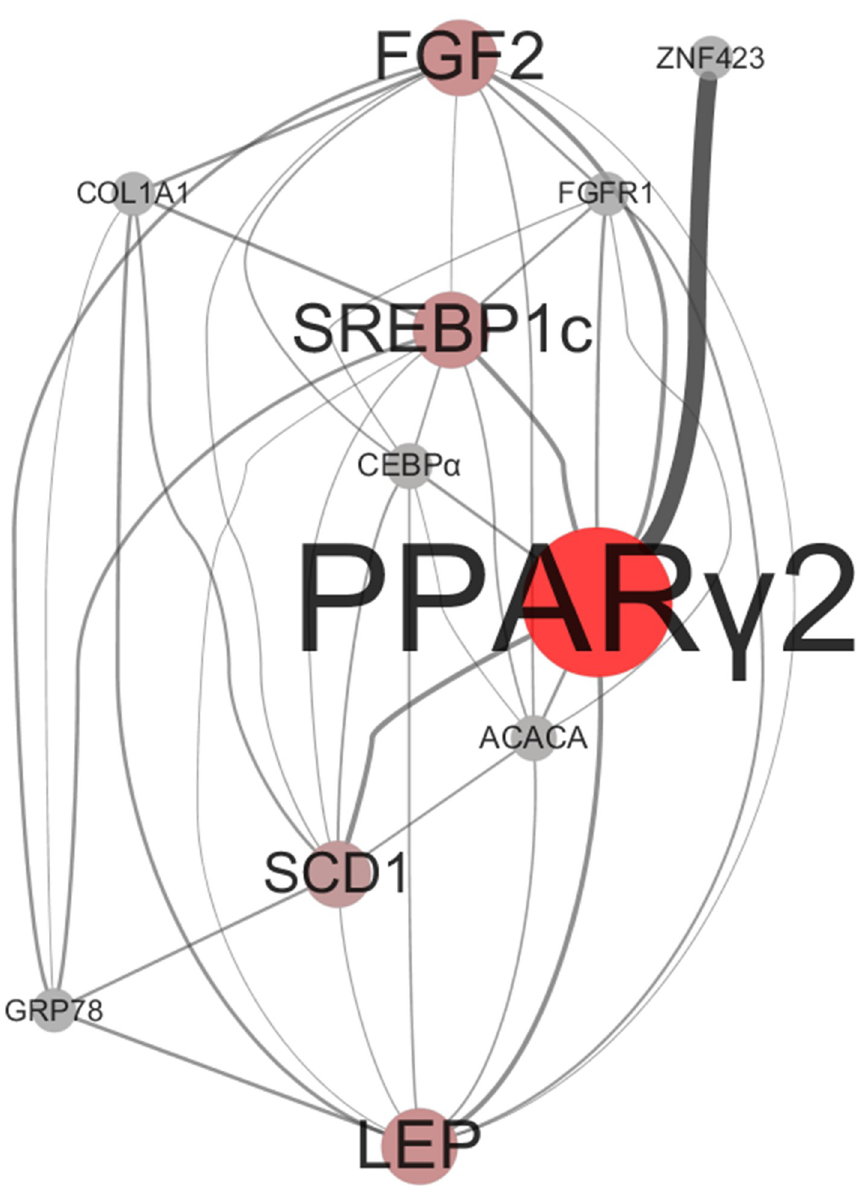
Fig 3. Gene association network composed of five hub genes. Node color and size: red and larger nodes represent hub genes with more links. PPAR γ 2 appears to be the super hub gene in the network with the highest connectivity. metabolism-related genes were placed in hierarchically arranged layers from top to bottom. Based on the betweenness centrality (BC) values of each node in the network, FGF2 , SREBP1c , PPAR γ 2 , SCD1 and LEP were identified as hub nodes, displaying higher connectivity within the network. PPAR γ 2 had the highest BC, occupying the center of the network. FGF2 was at the top of the network and was significantly positively correlated with most genes except ZNF423 , which was only significantly correlated with PPAR γ 2 . In addition, the expression of FGFR1 was positively correlated with that of SREBP1c , CEBP α , PPAR γ 2 , ACACA and LEP . There was a sig- nificant positive correlation among FGF2 , COL1A1 , SREBP1c , GRP78 , SCD1 and LEP .